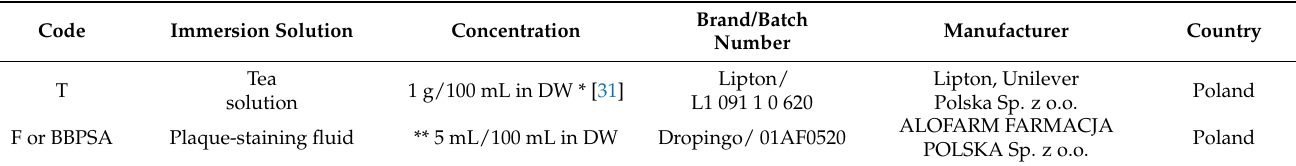
Table 2. Immersion solutions used in this